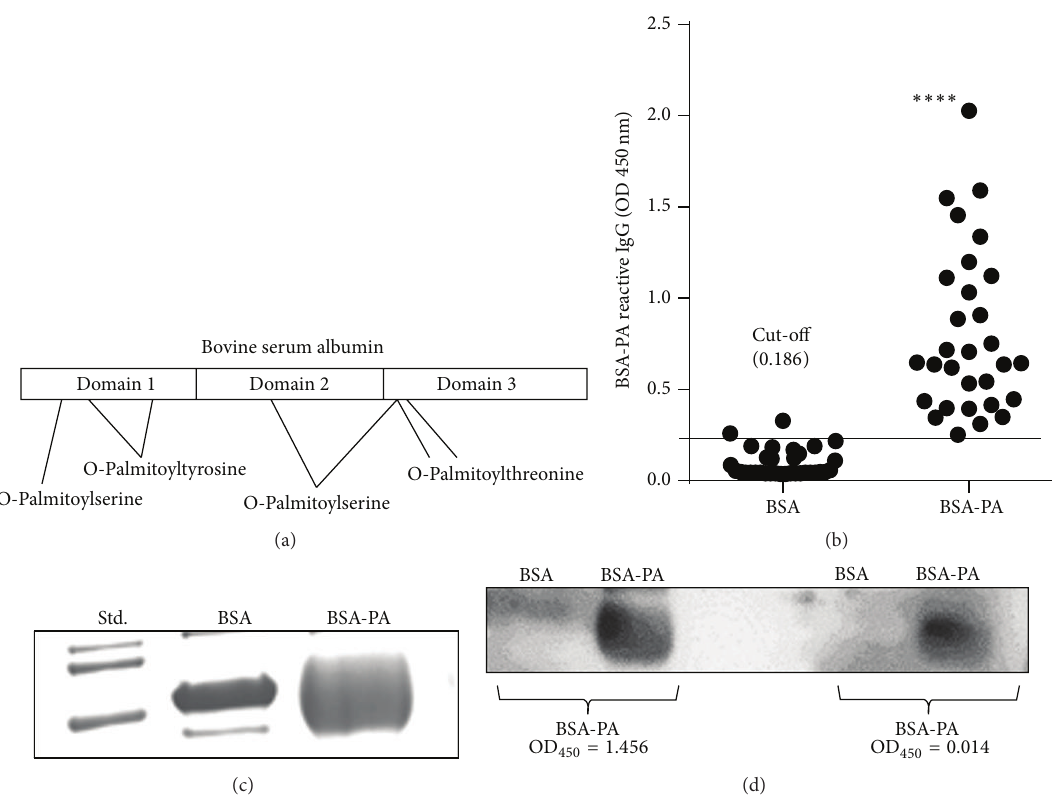
Figure 2: Patient serum reacts with palmitoylated BSA. (a) Diagram of BSA palmitoylation sites. Seven accessible hydroxyl groups that can be palmitoylated are present on serine, tyrosine, or threonine of BSA. (b) ELISA identification of BSA-PA reactive IgG antibodies. En Balance baseline serum samples from Hispanic diabetic patients were tested by ELISA for IgG Abs that react with BSA (2/36) or BSA-PA (36/36). The cut-off value for positive antibody reactivity against BSA-PA ( > 0.186) was defined as an absorbance greater than two standard deviations above the mean value for BSA. (c) A Coomassie stained gel of palmitoylated BSA (BSA-PA). Palmitoylated BSA migrates faster on the gel than BSA due to an increased ( − ) charge contributed by SDS association with the palmitoyl groups. (d) Western blot can detect differential levels of Ab that react with BSA-PA. Western blots with BSA alone (10 𝜇 g) and BSA-PA (60 𝜇 g) were probed with total serum from Hispanics with type 2 diabetes which had a high OD 450 (OD = 1.456 ) or low OD 450 (OD = 0.014 ) as determined by ELISA for reactivity with BSA-PA. Anti-human IgG was the secondary antibody. (c) Statistical analysis was accomplished with a Wilcoxon-ranked sign test. ∗∗∗∗ 𝑝 < 0.0001